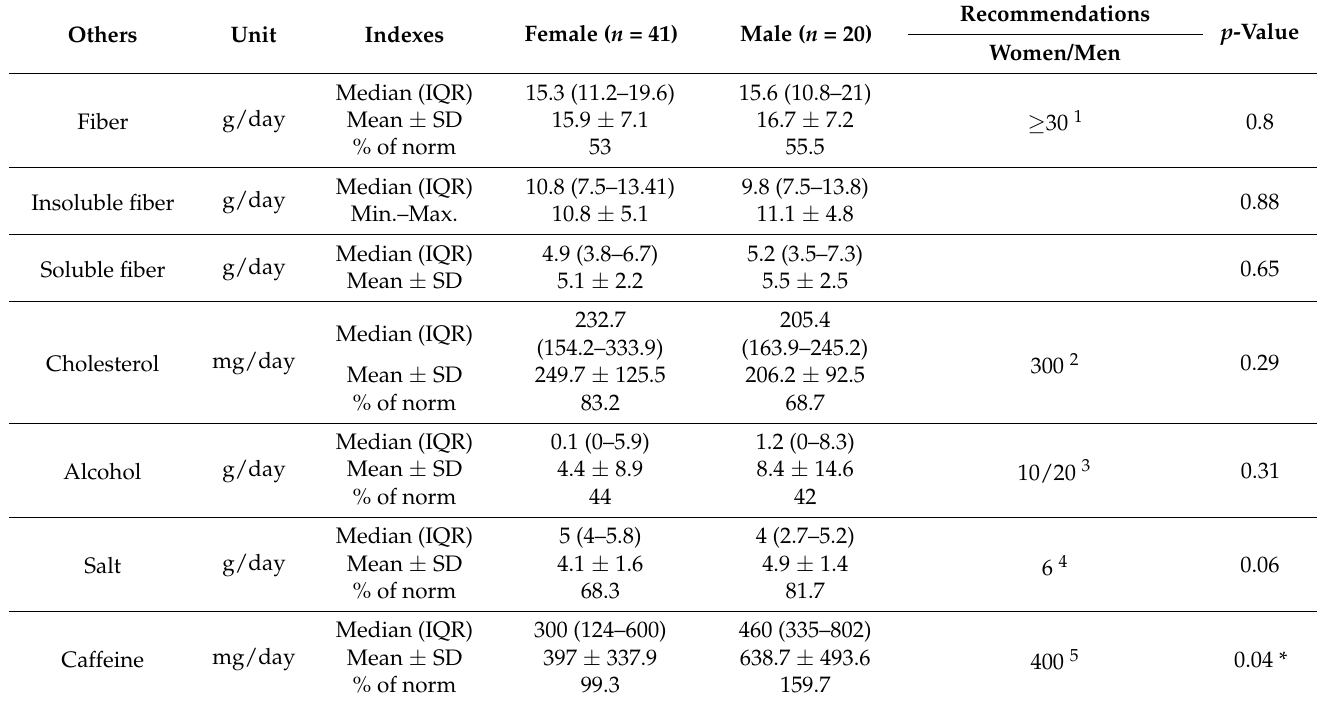
Table 4. Other nutrient intake in patients with RA ( n =